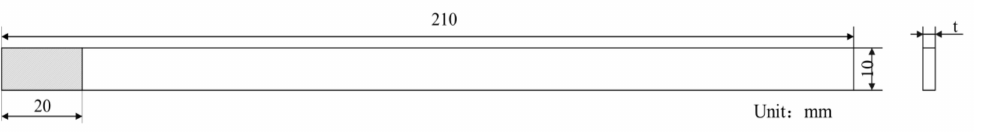
Figure 6. Schematic diagram of the size of the test